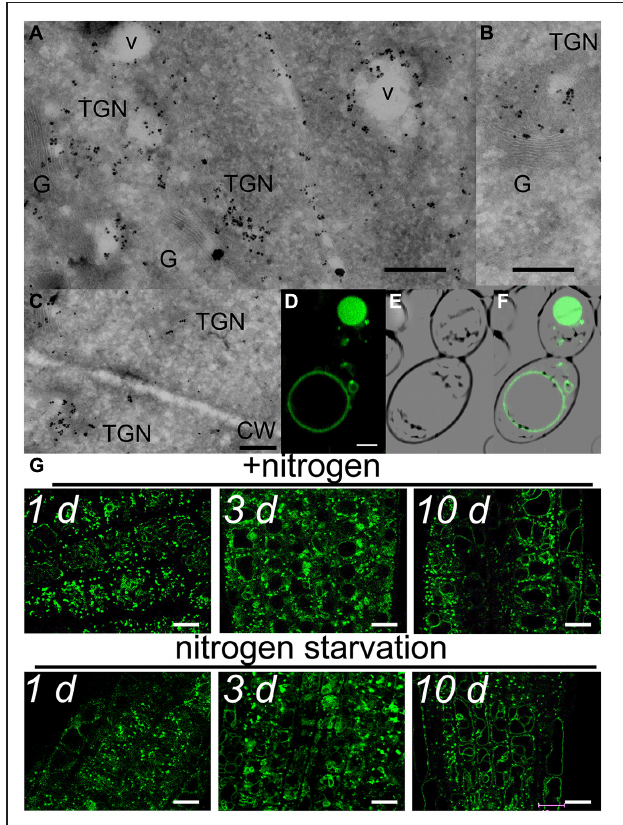
FIGURE 4 | Subcellular localization of CAT9–GFP. Transmission electron microscopic images of ultrathin root cryosections of immunogold-labeled pUbq10:: CAT9–GFP (A,B,C) . v, vesicular structure; TGN, trans -Golgi network; G, Golgi; CW, cell wall with adjacent plasma membranes. The construct was expressed from its endogenous promoter Scaling bars: 500 nm. (D) Fluorescence of heterologously expressed CAT9–GFP in yeast, (E) bright field image, (F) overlay. Scaling bar: 2 μ m. (G) Fluorescence pattern of pCAT9:: CAT9–GFP in roots a few mm behind the root tip in the presence of nitrogen (upper row) or after transfer to plates lacking nitrogen for 1, 3, or 10 days (lower row). Scaling bars: 10 μ m. The complemented line (cl) in